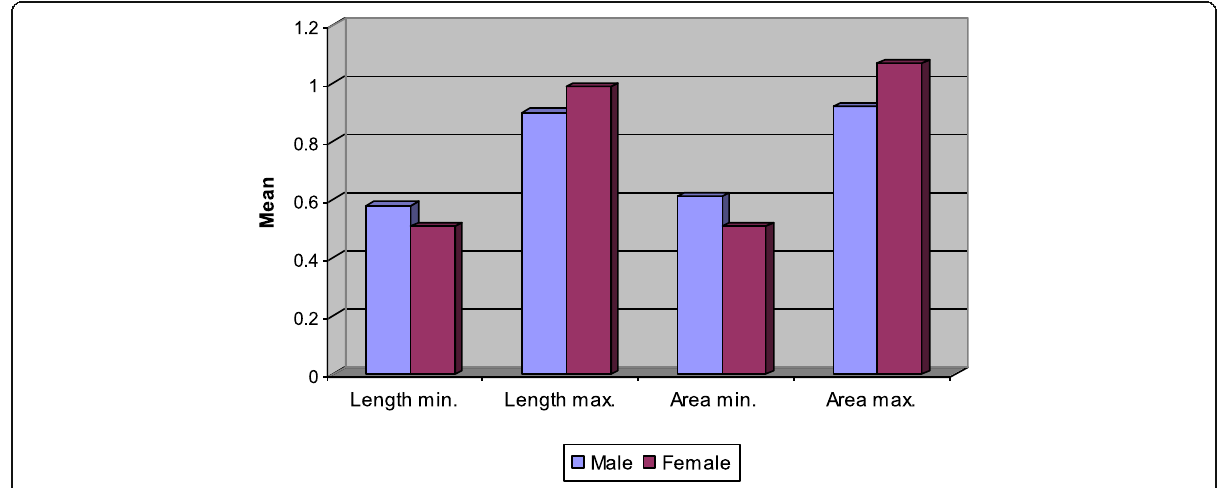
Fig. 6 Bar chart showing comparison between males and females as regard length and